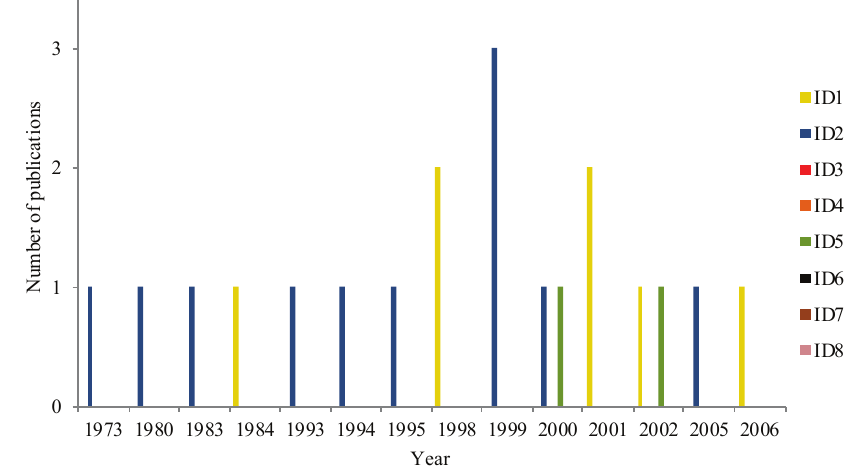
Figure 1. Research trends of EVs and distribution networks, 1973–2006.